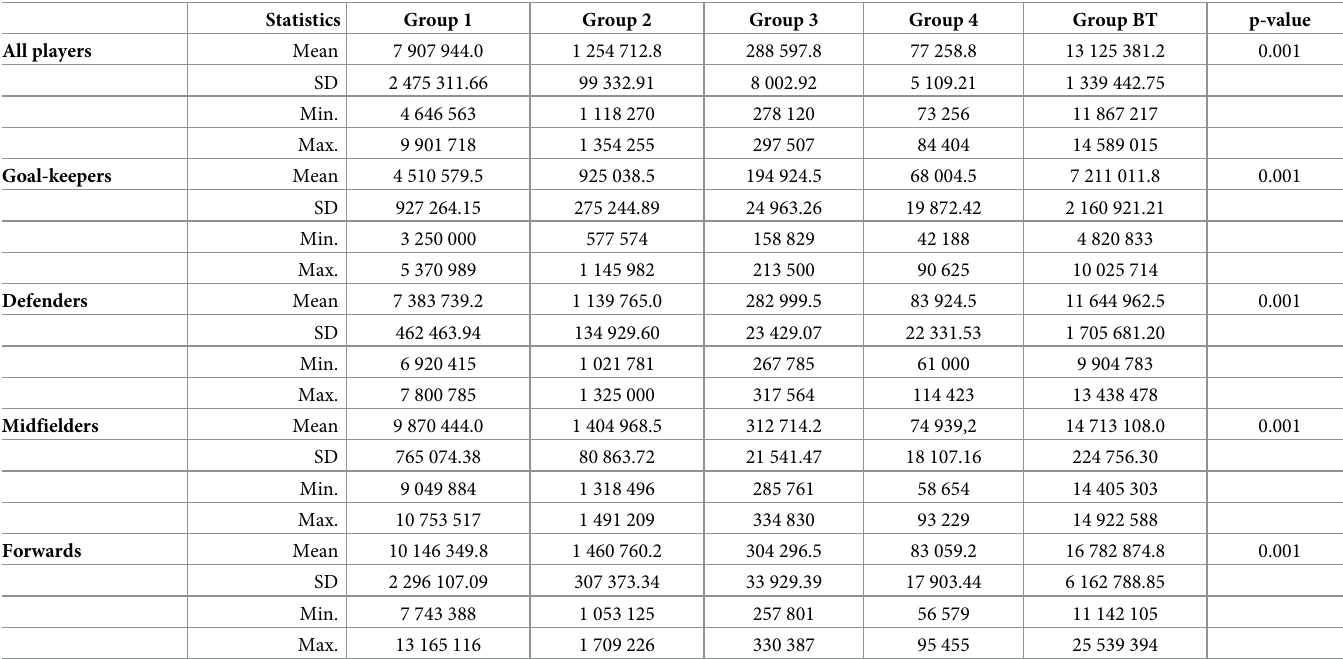
Table 6. Differences between market value across groups—Kruskal-Wallis